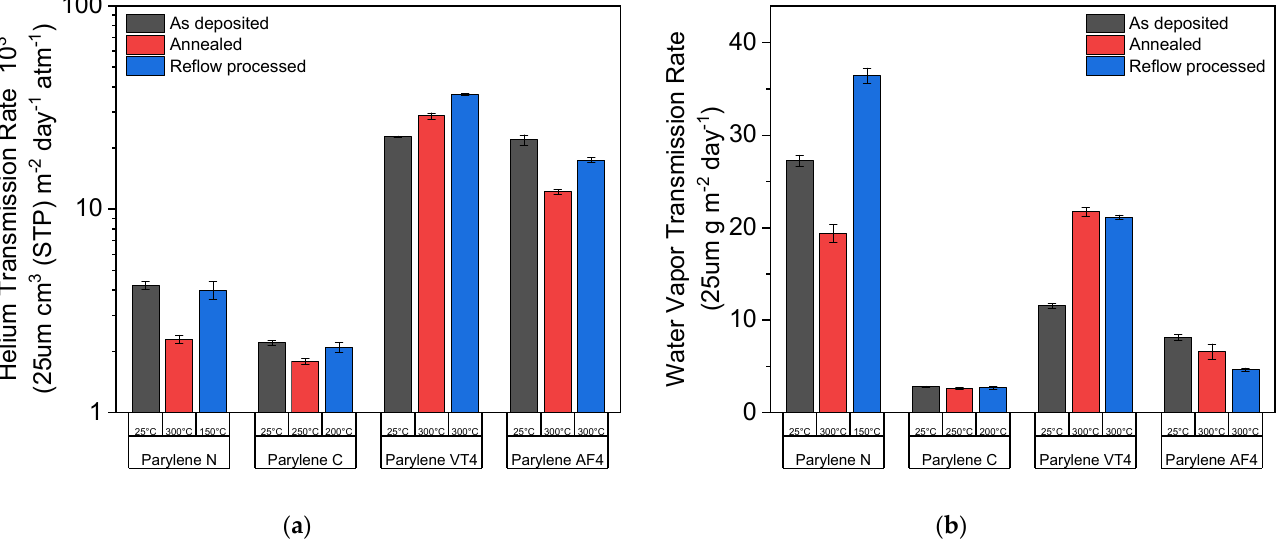
Figure 5. Permeation measurements: ( a ) helium transmission rate (HTR) and ( b ) water vapor transmission rate (WVTR) as a function of temperatures and for the different parylene types.